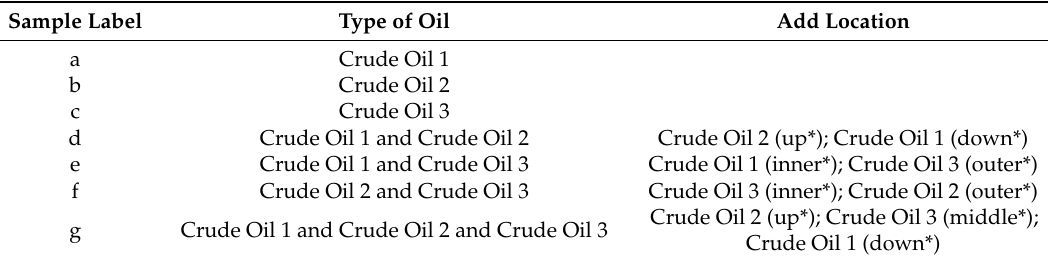
Table 1. Types of crude oil contained in the